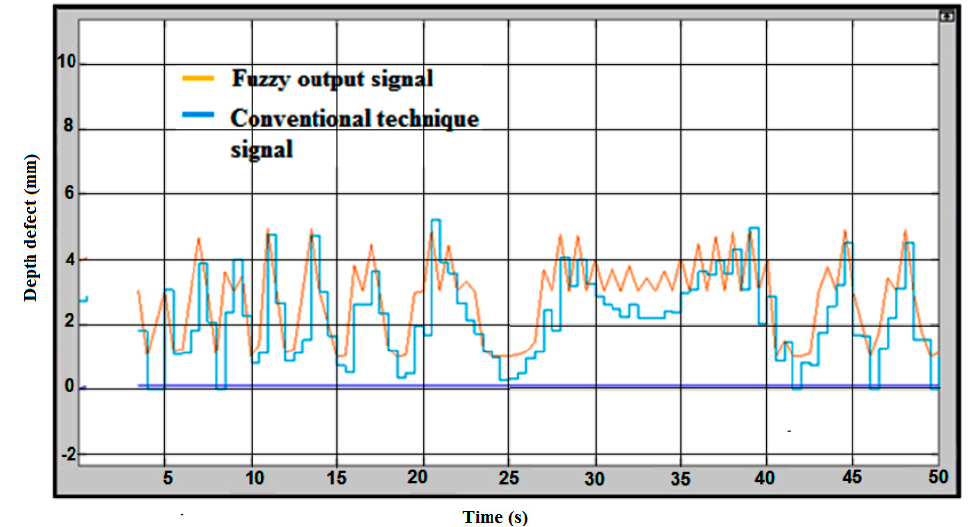
Figure 12. Fuzzy Logic for Error Compensation Signal Output without Coating Thickness.